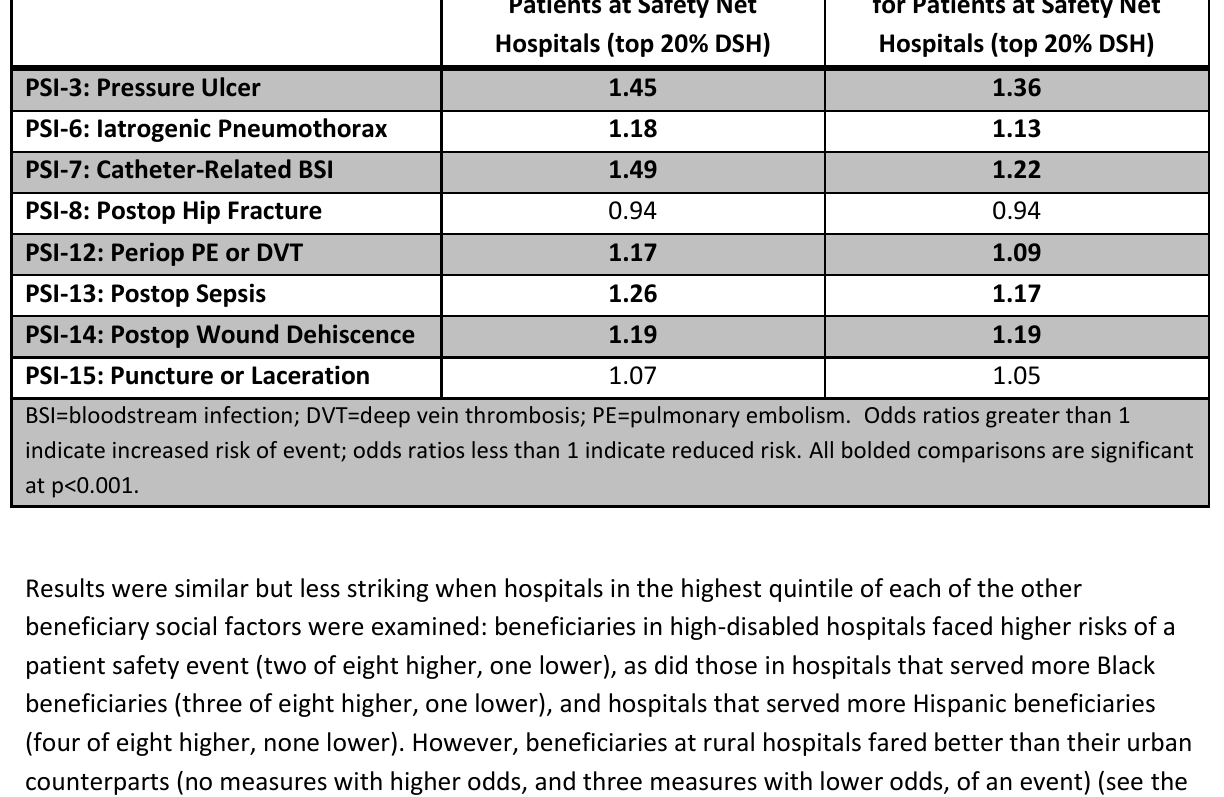
Table 6.6: PSI Measure Performance, Safety-Net Versus Non-Safety-Net Hospitals